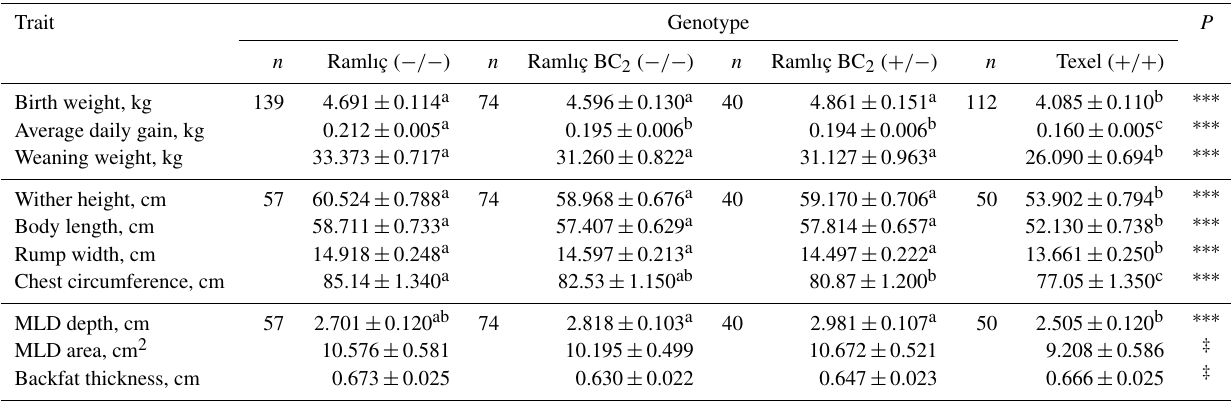
Table 1. Least-squares means and standard errors for growth traits and pre-slaughter carcass traits at weaning in contemporary Ramlıç, BC 2 ( − / − ), BC 2 ( + / − ) and Texel lambs.